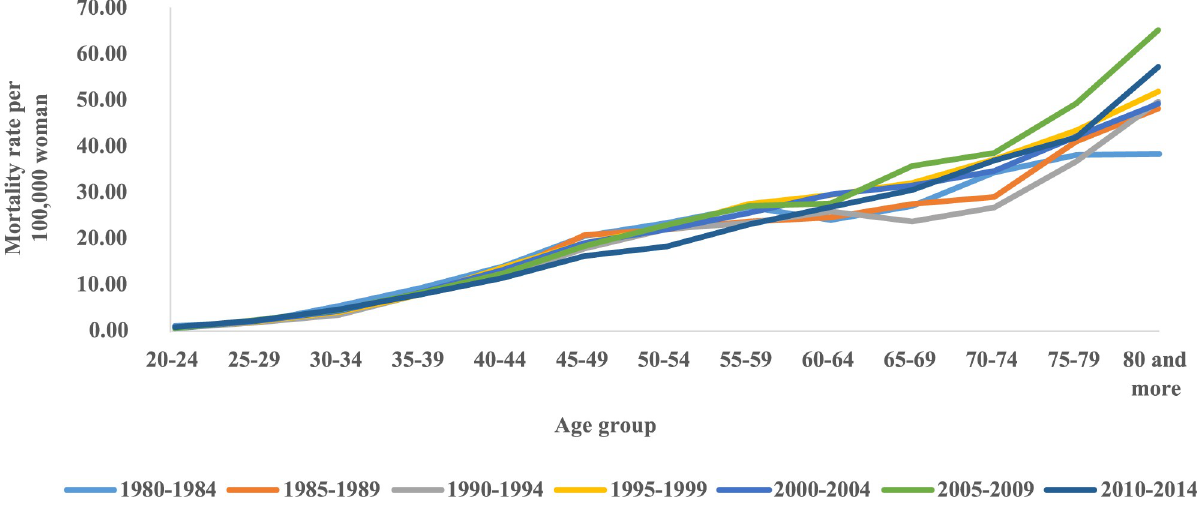
Fig 1. Cervical cancer mortality rates by age group and death period in Northeast Brazil, 1980–2014.